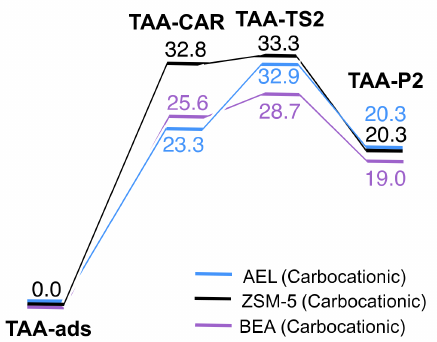
Figure 8. Energies ( ∆ E, kcal mol − 1 ) are depicted along the reaction coordinate for the dehydration of TAA through a carbocation intermediate (TAA-CAR) with negligible barrier to 2-methyl-2-butene (TAA-P2). “TAA-ads” refers to TAA adsorbed at the active site of the relevant